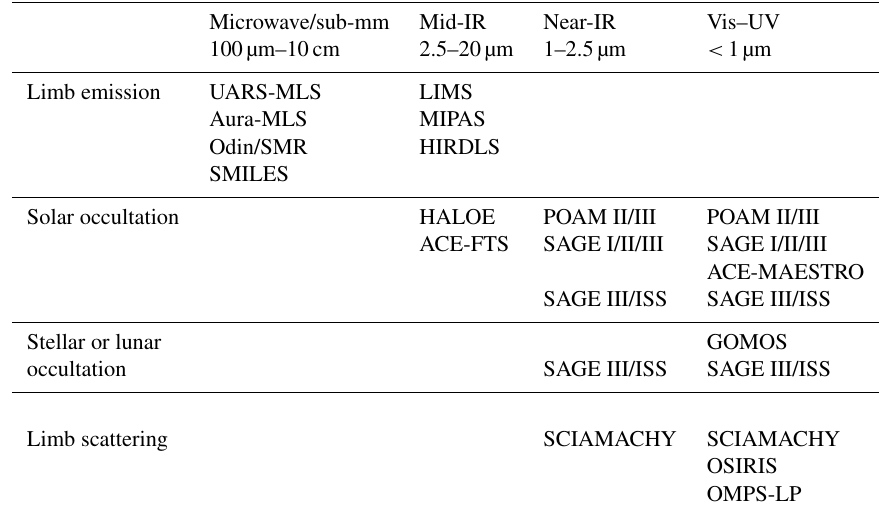
Table 3. Instruments classified according to their observation geometry and wavelength categories. Only instruments that participated in the SPARC Data Initiative are